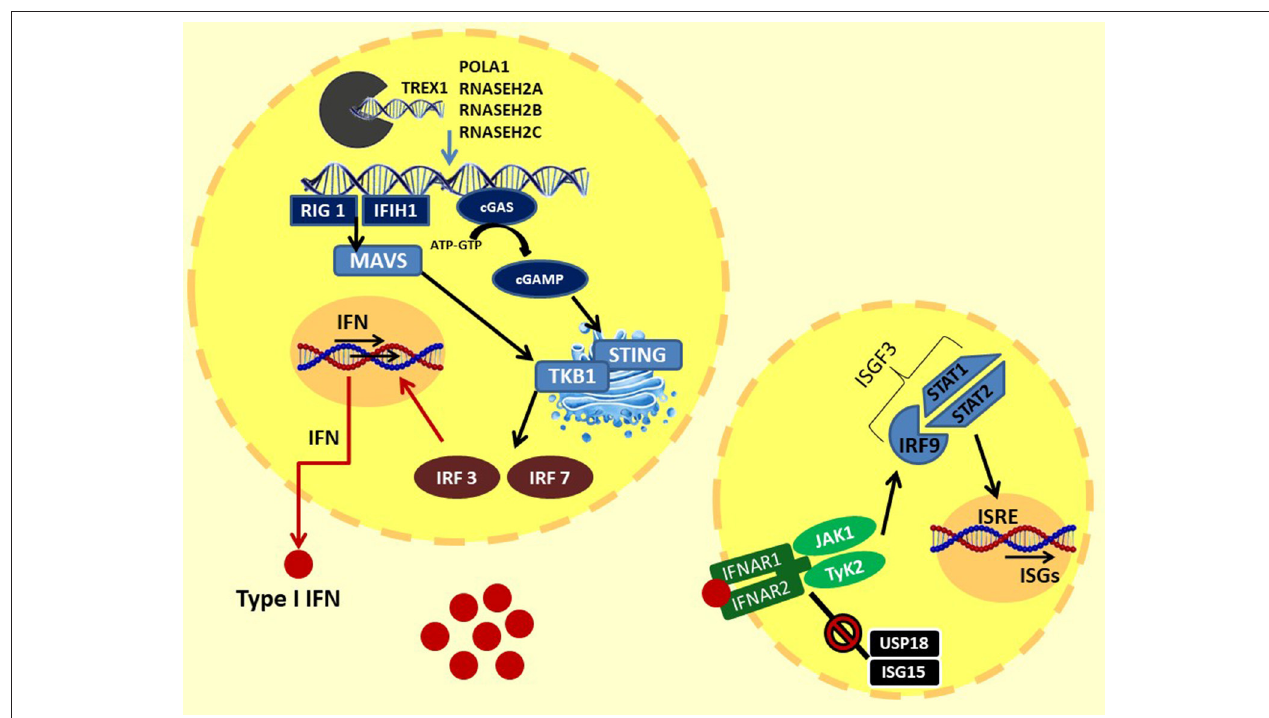
FIGURE 1 | Type I IFN signaling: the intracytoplasmatic accumulation of viral (or endogenous due to loss of function of the enzymes responsible for degradation) nucleic acids is sensed by two systems: (1) the cytoplasmic DNA receptors cyclic GMP-AMP synthase cGAS: intracellular dsDNA activate cGAS, leading to the production of cGAMP. cGAMP binds and activates STING in ER, which translocates into the Golgi apparatus. Here, the STING C-terminal tail recruits TBK1. TBK1 induces the coupling and the phosphorylation of IFR3 and, consequently, IFR7. (2) The cytosolic RNA helicases RIG-I–MDA5 system: intracellular dsRNA activates MDA5 and RIG I, which bind and activate MAVS in the mitochondrial membrane, forming the MAVS signaling complex. MAVS triggers downstream TBK1, than activating IRF3 and IRF7. Finally, IRF3 and IRF7 translocate to the nucleus and induce the transcription of IFN- β and IFN- α , respectively. Type I IFNs, through autocrine and paracrine action, bind to IFN receptors. The IFNR dimerization recruits JAK1 and TyK2 proteins. This activation promotes the STAT1–STAT2 dimerization and the binding of IRF9 to assemble the heterotrimeric transcription complex ISGF3. In the nucleus, ISGF3 binds to IFN-stimulated response elements (ISRE), promoting the expression of interferon-stimulated genes (ISGs). At the same time, IFN signaling is regulated by a negative feedback mechanism by the USP18–ISG15 system. The USP18 binds the IFNAR2 subunit, decoupling it from JAK1 and inhibiting the propagation of the next signal. ISG15 prevents the degradation of UBS18 by SPK2. TREX1, DNA 3 ′ –repair exonuclease 1; RNASEH2, ribonuclease H2; POLA1, polymerase- α ; cGAS, GMP-AMP synthase; cGAMP, 2 ′ 3 ′ GMP-AMP; STING, STimulator of INterferon Genes; TBK1, TANK-binding kinase 1; MAVS, mitochondrial antiviral-signaling protein; IRF3, IFN regulatory factors 3; IRF7, IFN regulatory factors; RIG-I, retinoic acid-inducible gene-I; MDA5, melanoma differentiation-associated gene 5; JAK1, Janus kinase 1; TyK2, tyrosine kinase 2; IRF9, IFN regulatory factors 9; ISGF3, interferon-stimulated gene factor 3; USP18, ubiquitin-specific peptidase 18; ISG15, interferon-stimulated gene 15; SPK2, S-phase kinase-associated protein